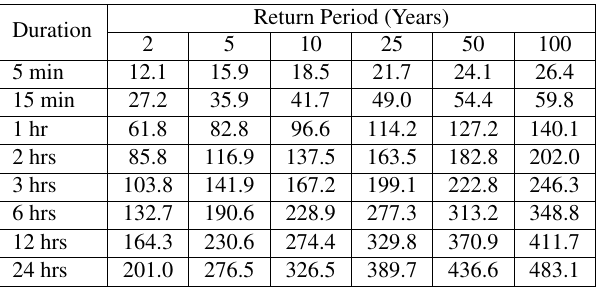
Table 1: The extreme values (in mm) of precipitation of the 6 hypothetical rainfall events based on RIDF data of Hinatuan PA- GASA Weather